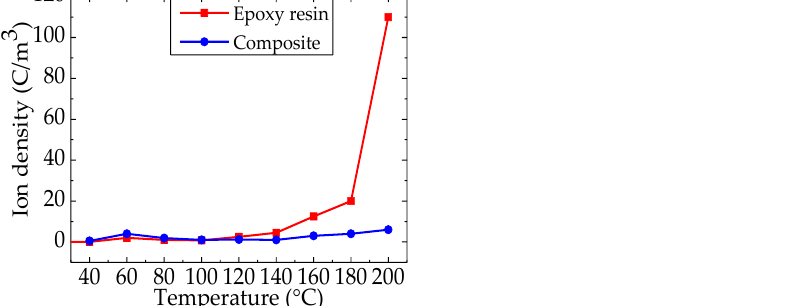
Figure 6. Ion density of epoxy resin and epoxy/nano−SiO 2 /micro−BN composite at varied tempera- tures.